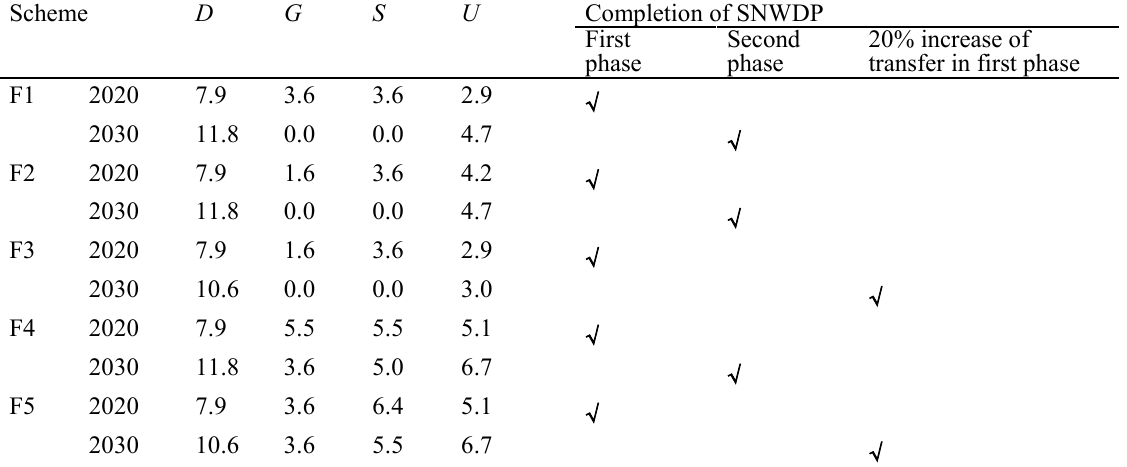
Table 1 The main constrained characteristics of the five different schemes (10 8 m 3 ).